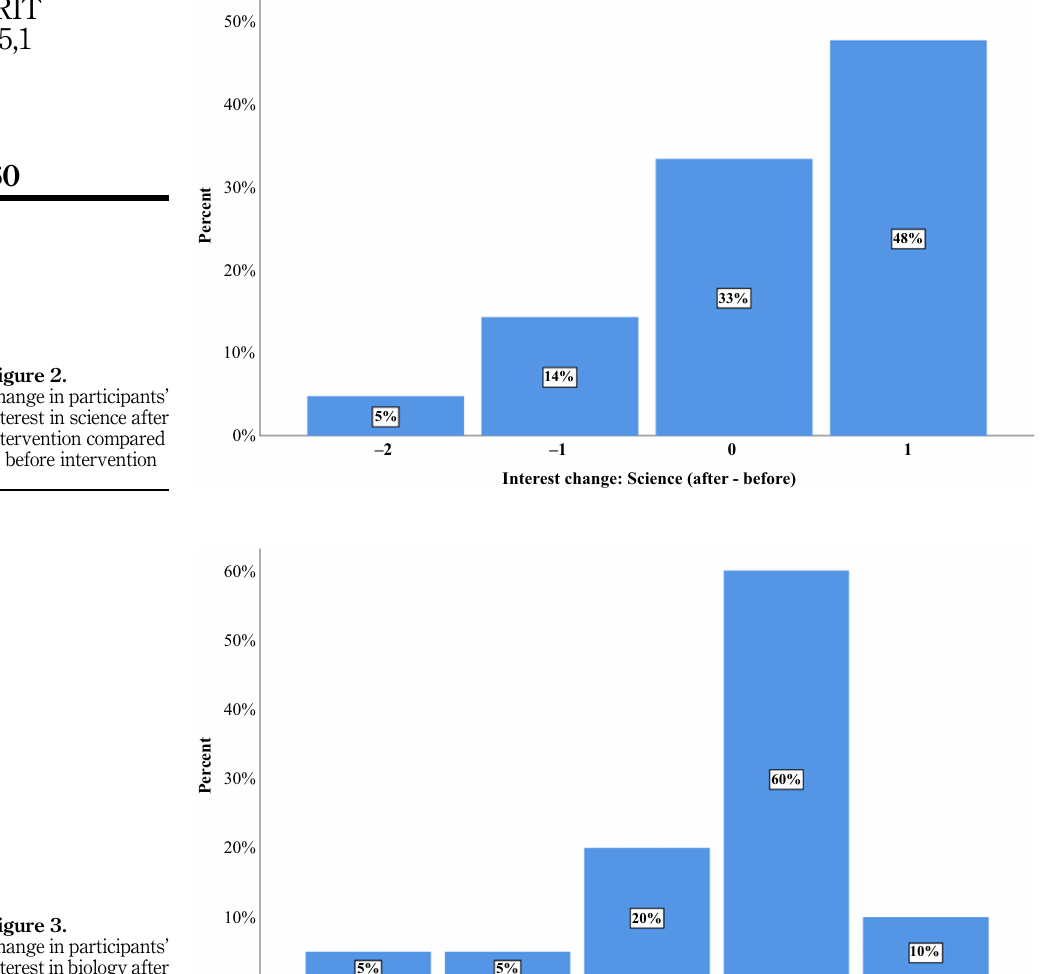
Figure 3. Change in participants ’ interest in biology after intervention compared to before